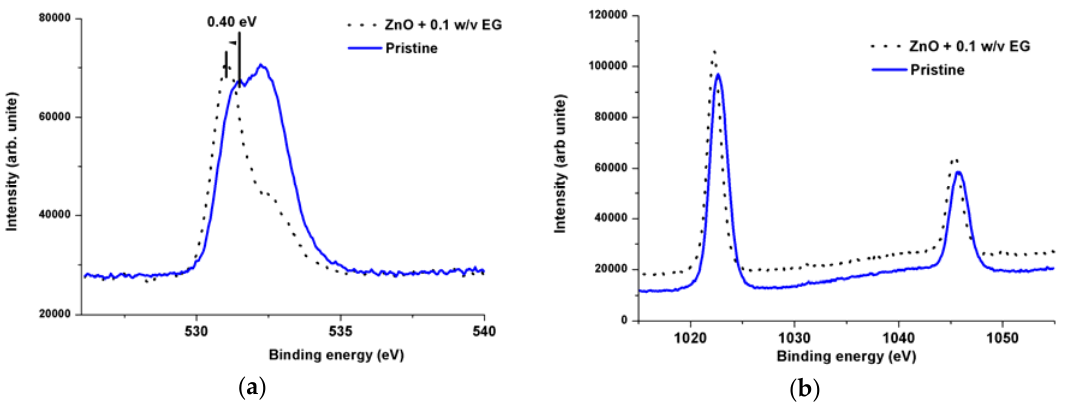
Figure 3. XPS study of the as grown ZNRs pristine (solid line) and doped with 0.1% w/v EG on Au ( a ) O 1s and, ( b ) Zn 2p spectra.